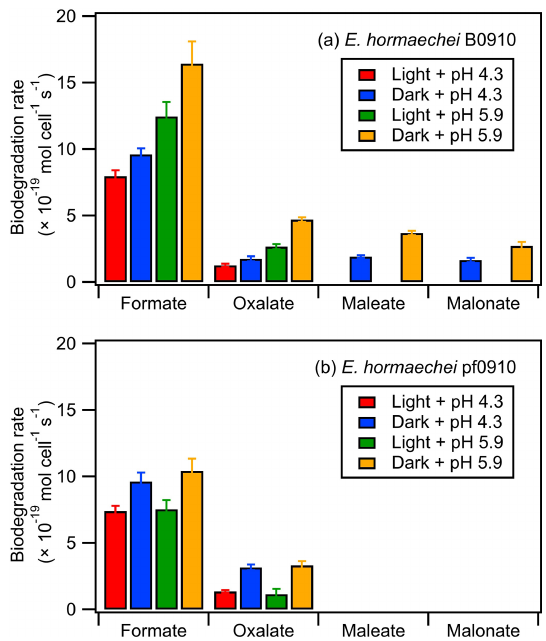
Figure 4. Biodegradation rates of oxalate, maleate, and malonate by (a) E. hormaechei B0910 and (b) E. hormaechei pf0910 under light and dark conditions at pH4.3 and pH5.9. Error bars represent 1 standard deviation from the mean biodegradation